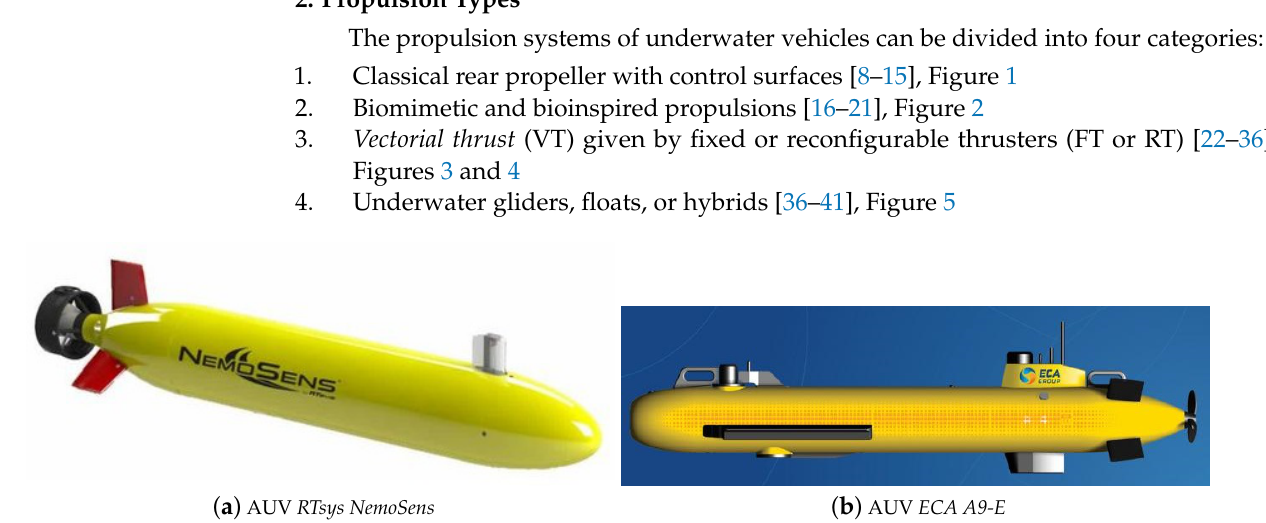
Figure 1. Examples of robots with classical rear propeller and control surface architecture